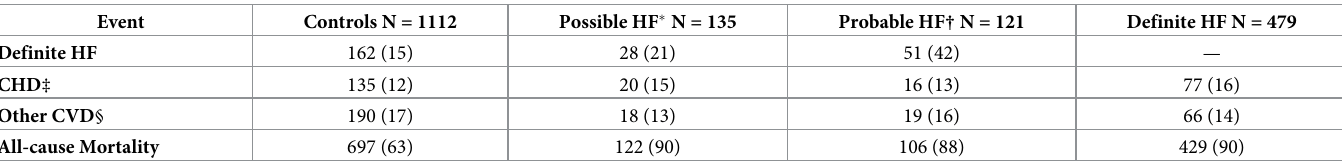
Table 2. Proportions of incident events on follow-up in the four study